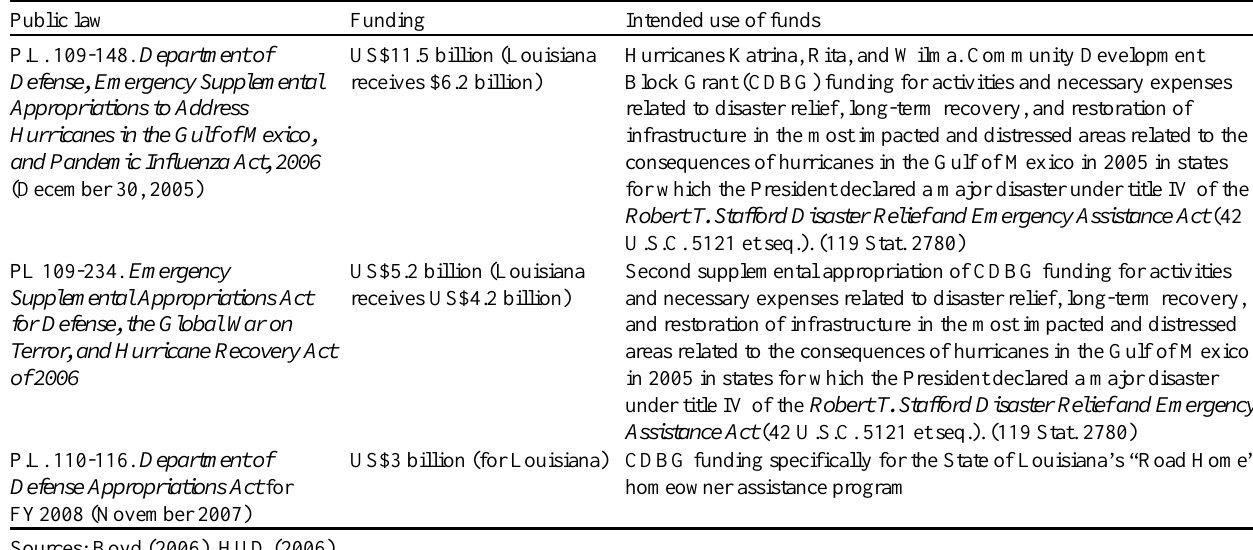
Table 1 . Funding history of Community Development Block Grant supplemental appropriations for Hurricane Katrina disaster